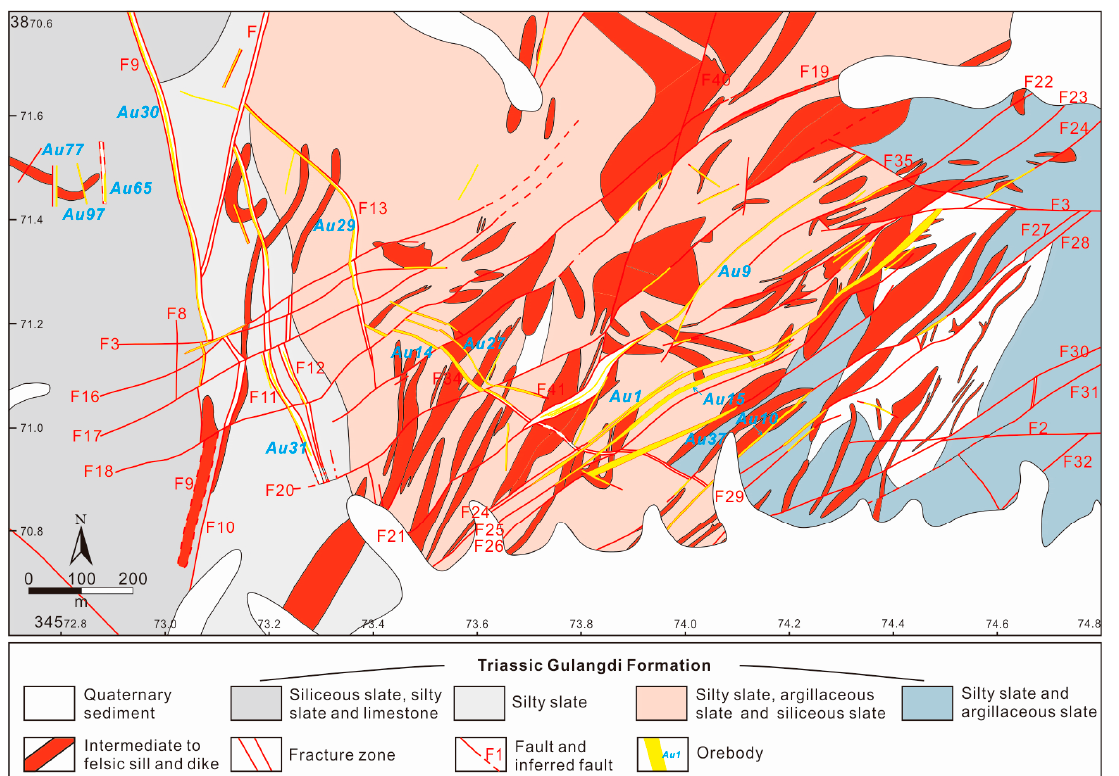
Figure 2. Sketch geologic map of the giant Zaozigou Au-Sb deposit in the West Qinling, China.